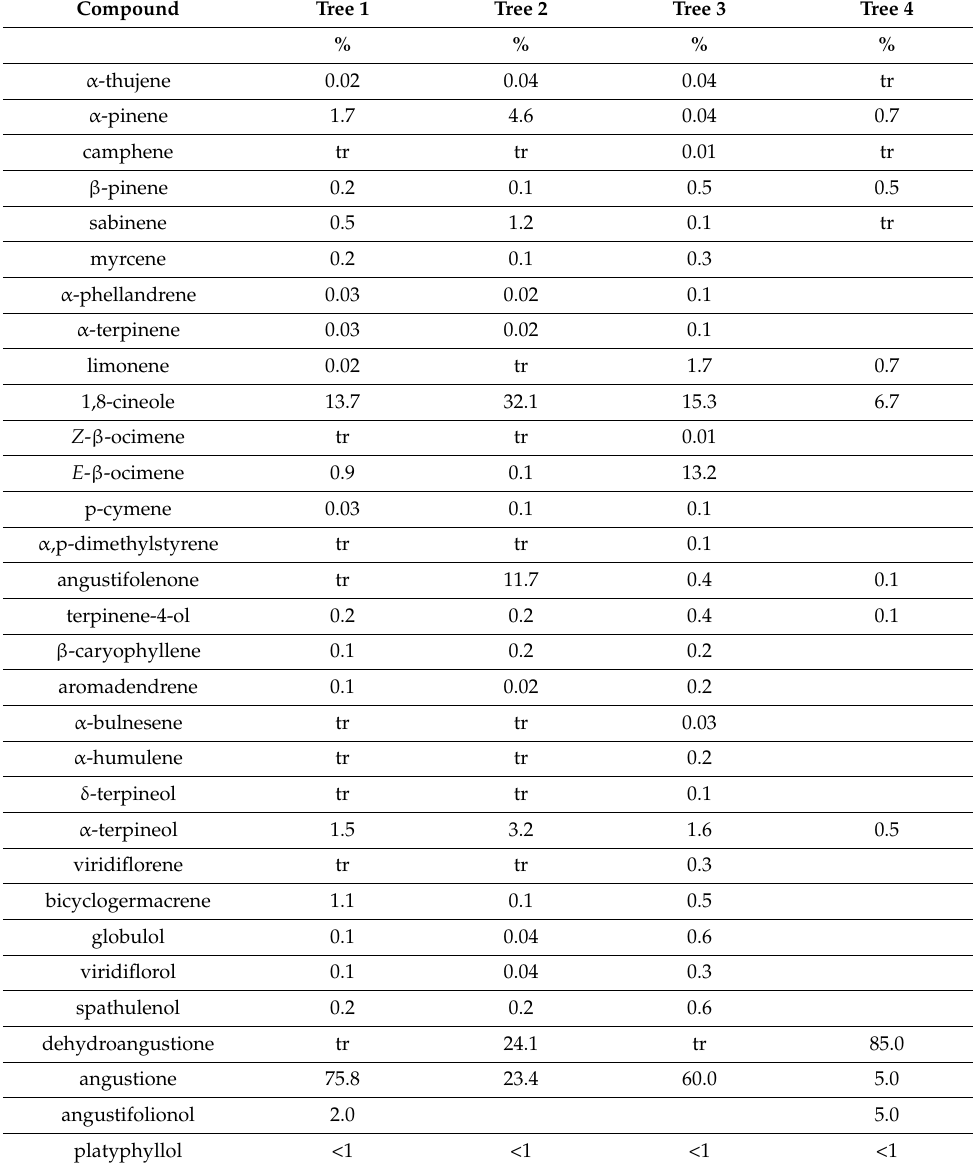
Table 3. Compounds identified in four trees of Backhousia angustifolia . Compound Tree 1 Tree